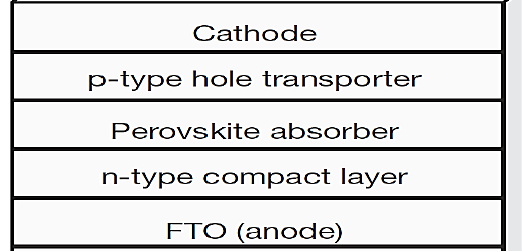
Figure 3. Solar cell structure examined in this